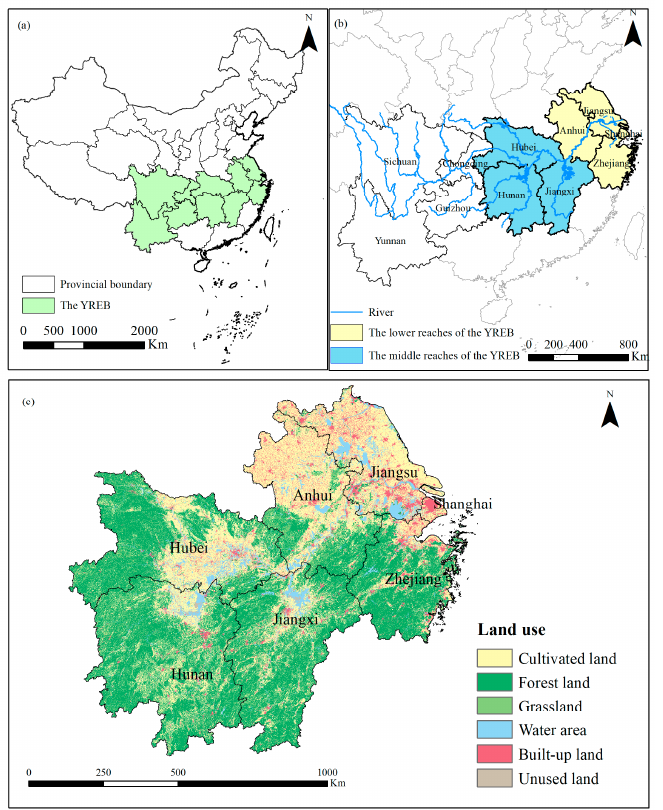
Figure 1. Geographic location and land use pattern of the YREBML ( a . The location of the YREBML in China; b . The provincial administrative division of the YREBML; c . Land user pattern of China; ( b ) The provincial administrative division of the YREBML; ( c ) Land user pattern of YREBML). Note: Datum: D_WGS_1984; Projection: WGS_1984_UTM_Zone_50N; Representation scale: 1: 17,000,000; Nominal scale: 1:250.